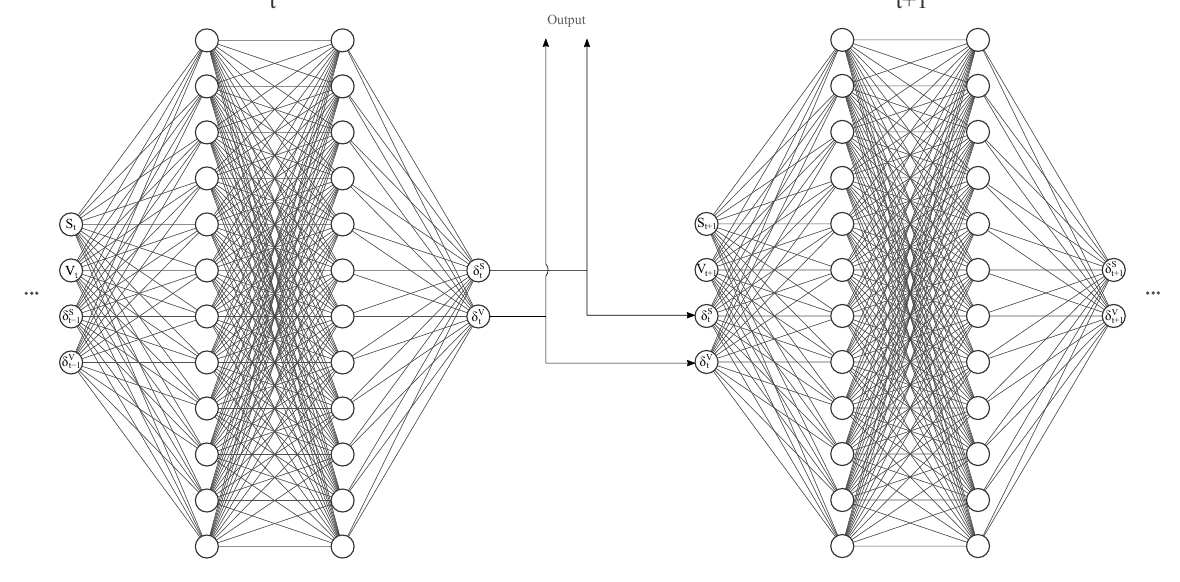
Figure 1. Original Network